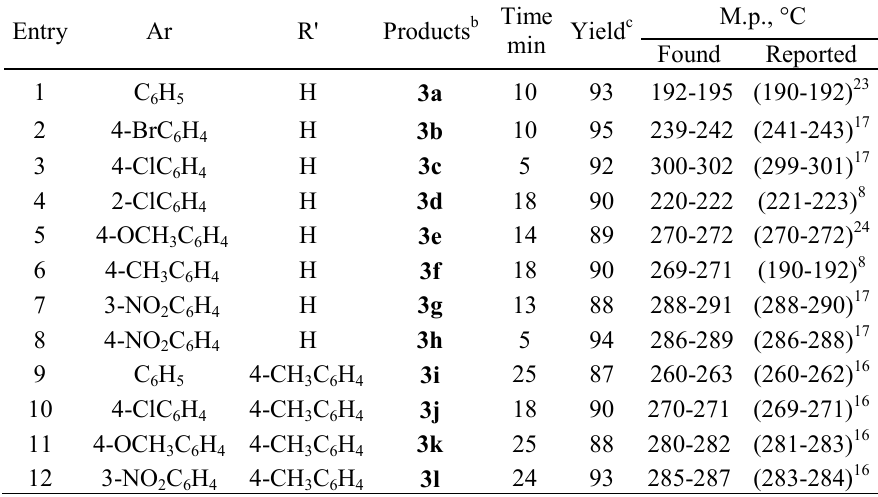
Table 2. Preparation of 1,8-dioxodecahydroacridines using PPA-SiO as catalyst a